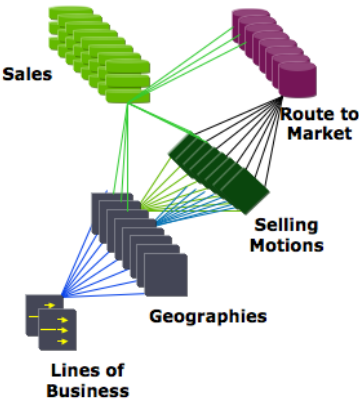
Figure 2 : Map of Potential Stakeholders to be Considered in an M.O.C